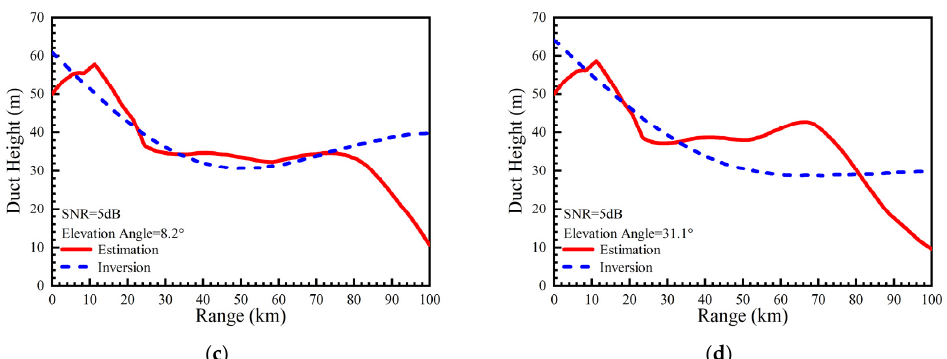
Figure 18. The estimated and inverted duct height at different satellite elevation angle and SNR cases: ( a ) the satellite elevation angle is 8.2° and the SNR is 15 dB; ( b ) the satellite elevation angle is 31.1° and the SNR is 15 dB; ( c ) the satellite elevation angle is 8.2° and the SNR is 5 dB; and ( d ) the satellite elevation angle is 31.1° and the SNR is 5 dB.